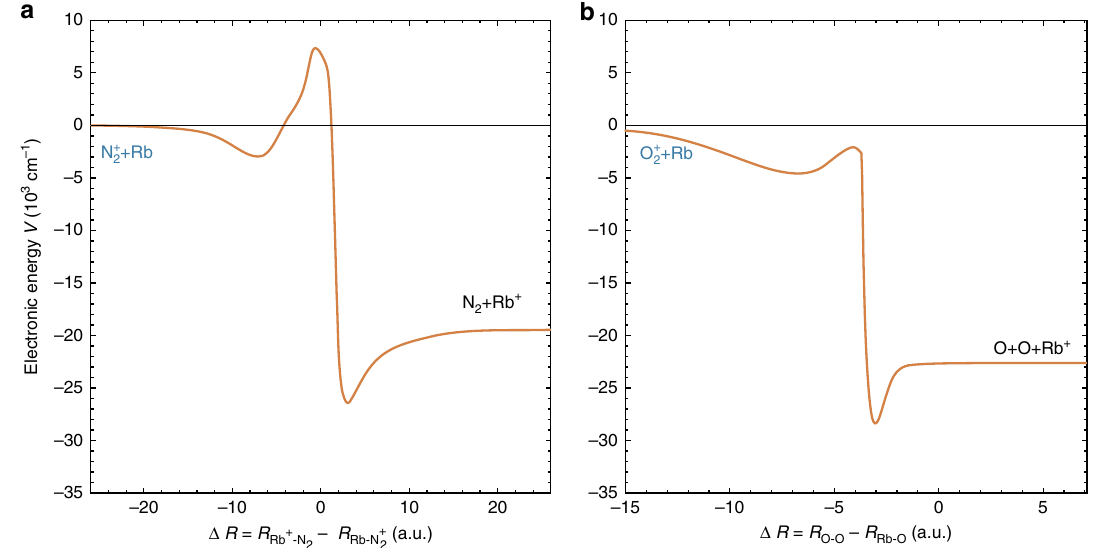
Fig. 5 Reaction pathways in linear collision geometry. Cuts of the PES along reaction coordinates for charge transfer in the linear collision geometry of the singlet channels of Rb( 2 S 1 = 2 ) reacting with a N þ